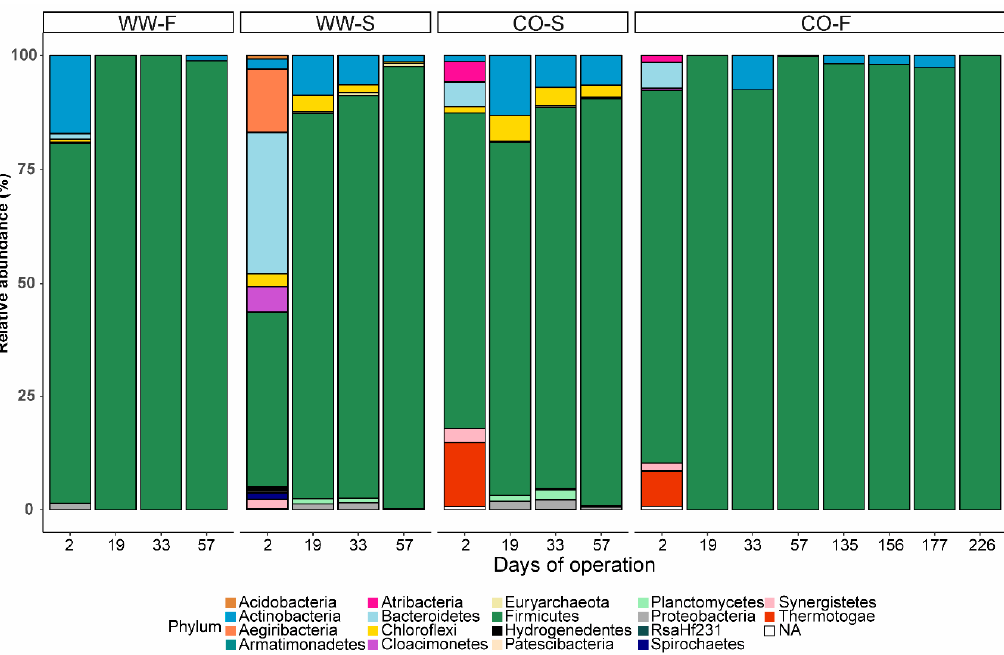
Figure 6. Relative abundance of microbial phyla (based on total bacterial and archaeal sequences) in reactors inoculated with sludge from a co-digestion plant (CO) or an anaerobic digestion process fed mixed sludge (WW) and fed food waste (F) or sewage sludge (S). Days of operation at the point of sampling are given on the x -axis.